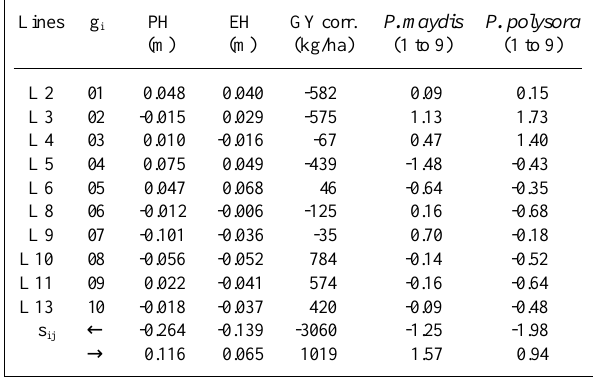
Table III - General combining ability estimates (g i ) for 10 maize lines and the range of the specific combining ability (s ij ) for plant height (PH), ear